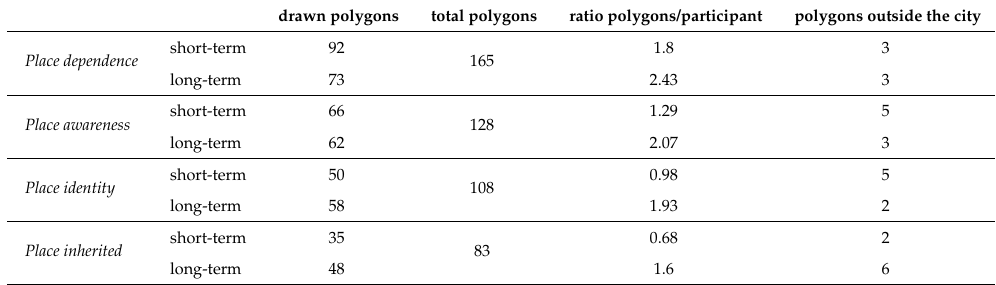
Table 3: Information on the number of drawn polygons for each dimension and participant